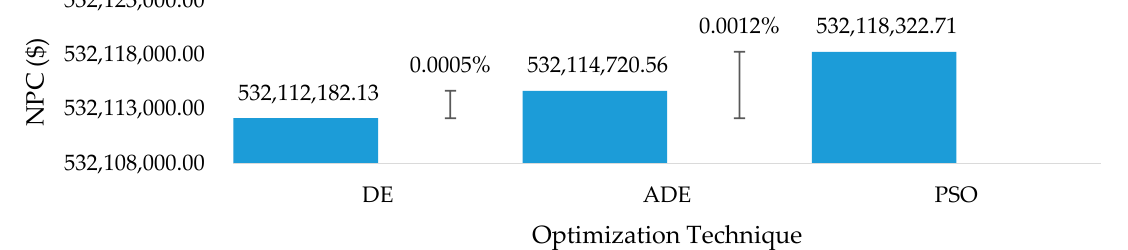
Figure 13. Comparison of NPC among Different Optimization Techniques.